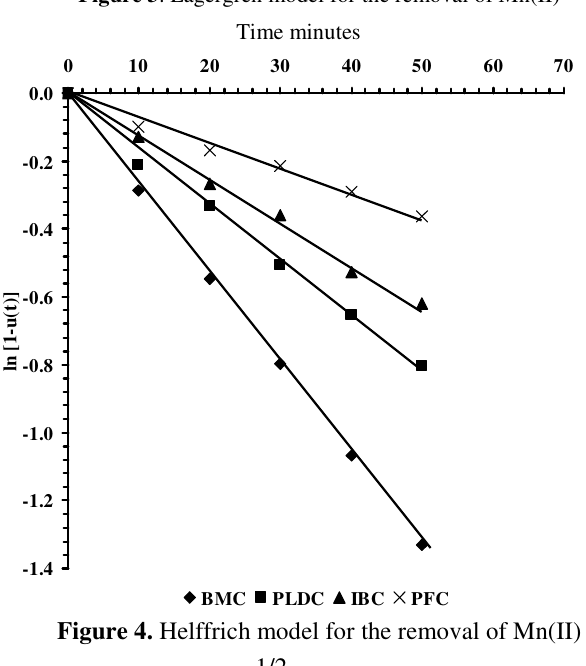
Figure 4. Helffrich model for the removal of